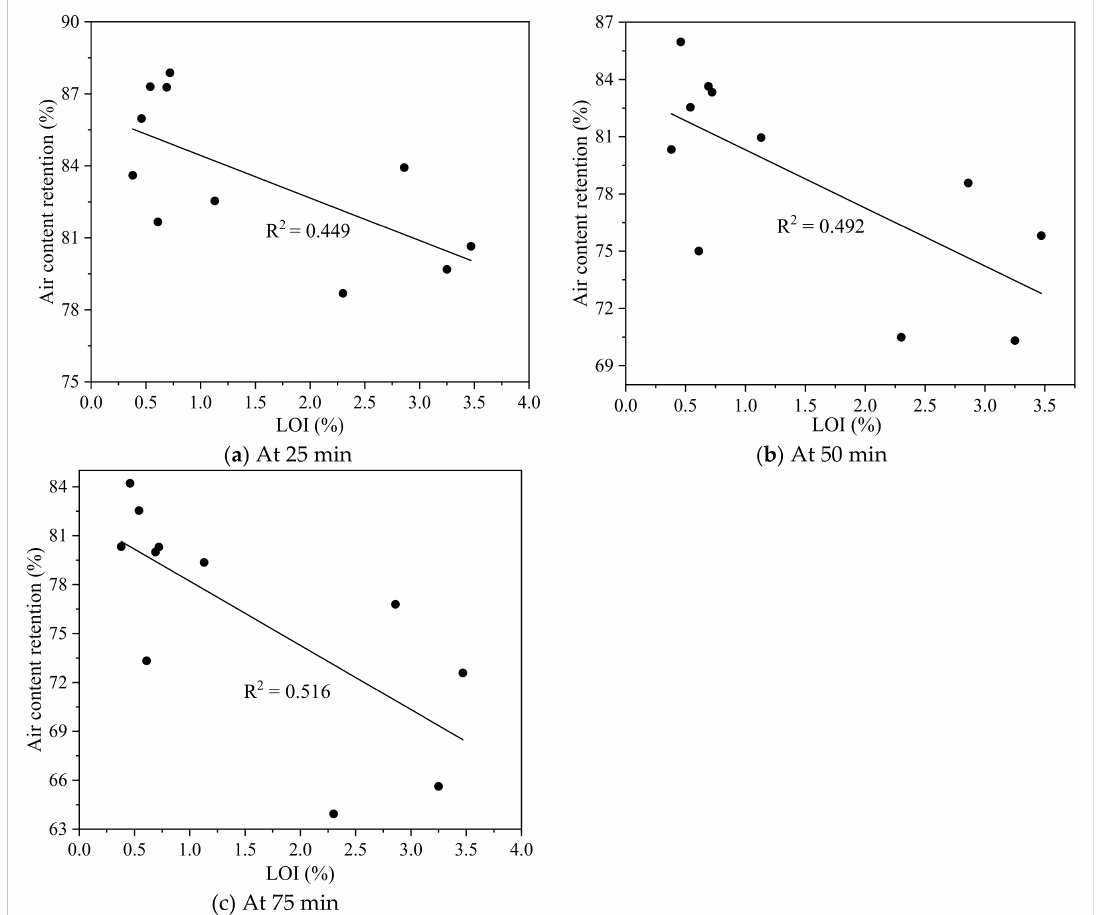
Figure 5. Correlation between air content retention and LOI of fly ash ( a ) At 25 min ( b ) At 50 min ( c ) At 75